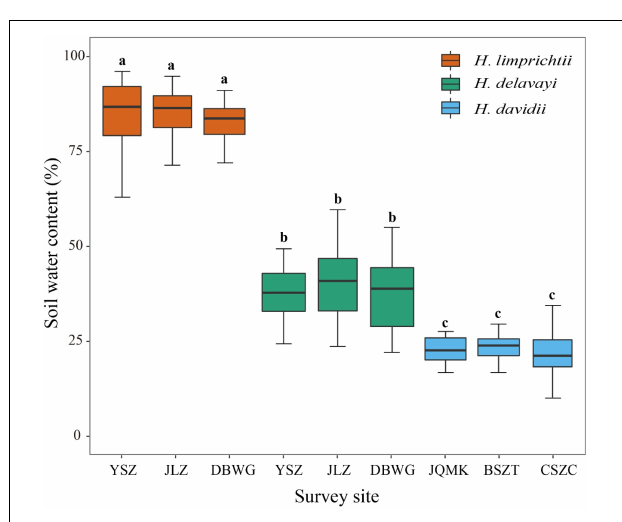
FIGURE 3 | Comparison of soil water content at different sites among three Habenaria species at Yulong Snow Mountain, Lijiang. Lowercase letters indicate significant differences at p <